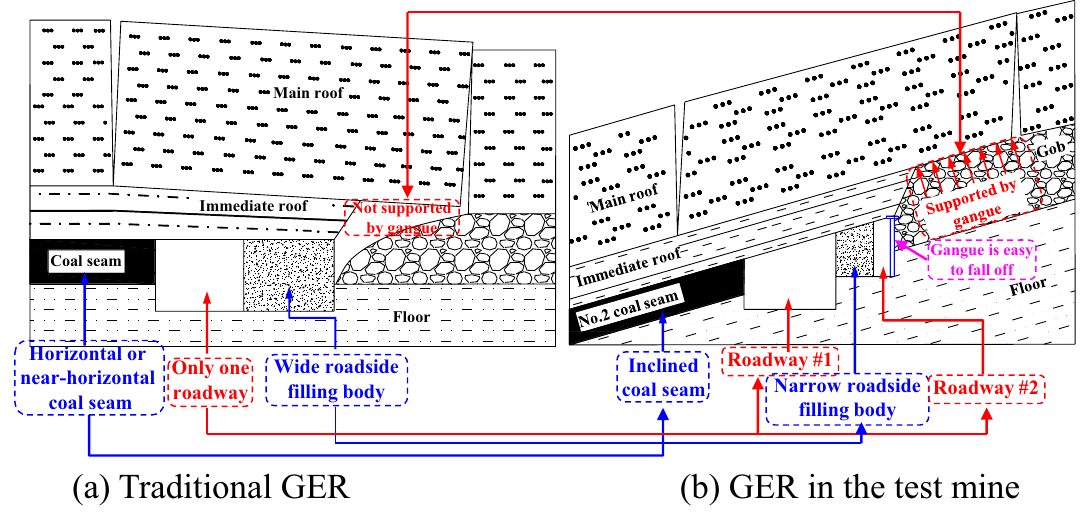
Fig. 1 Comparison between traditional GER and GER with double roadways in the test